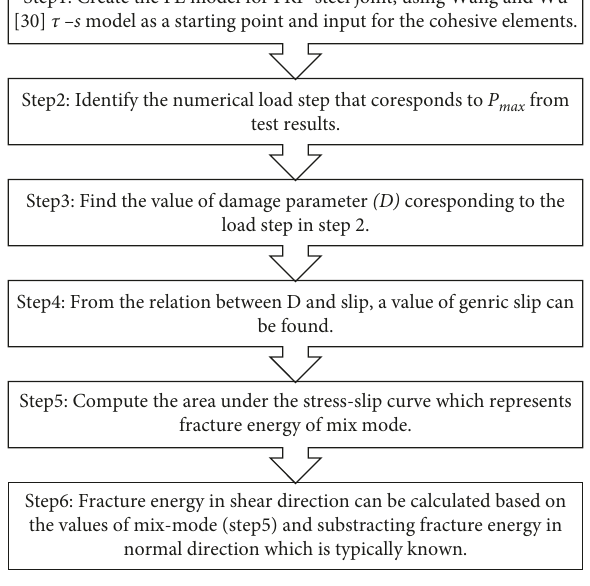
Figure 7: Inverse analysis procedure to determine the fracture energy of FRP-steel